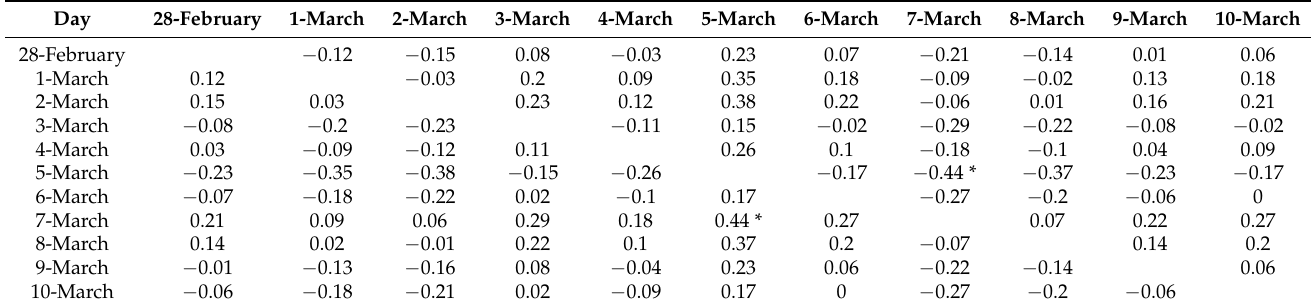
Table 8. Post hoc test for all pairwise comparisons of LMF-HRV-correlation mean between days for the United Kingdom’s group (* p < 0.05).